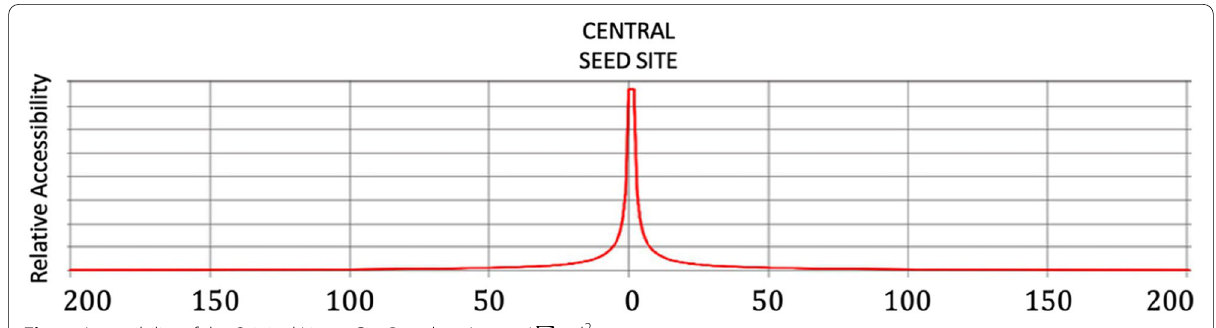
Fig. 4 Accessibility of the Original Linear City Based on A n ∝ 1 /